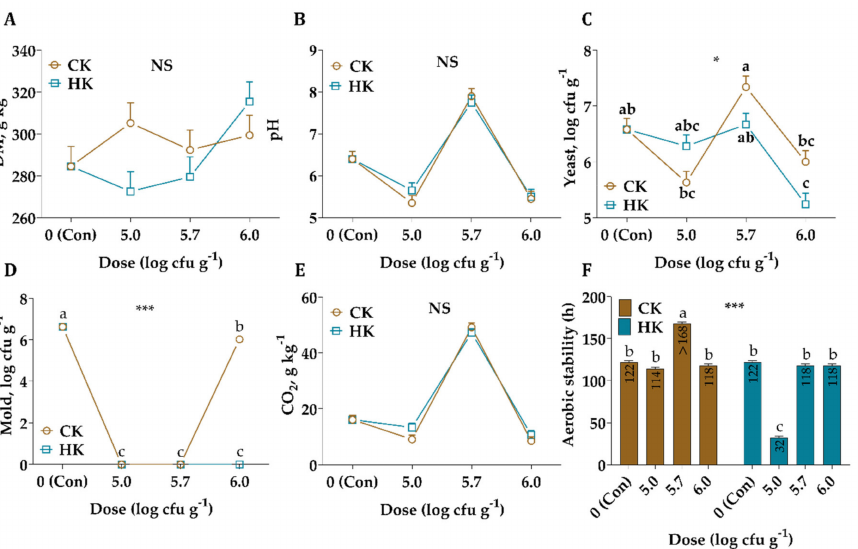
Figure 3. Changes in dry matter (DM, ( A )), pH ( B ), yeast ( C ), mold ( D ), carbon dioxide (CO 2 , ( E )), and aerobic stability ( F ) of alfalfa silages after 7 d of aerobic exposure. CK: commercial kefir, HK: homemade kefir, cfu: colony-forming units. The values with different letters (a, b, c) in each graph are statistically different ( p < 0.05), NS: not significant, * : p < 0.05, *** : p < 0.001.